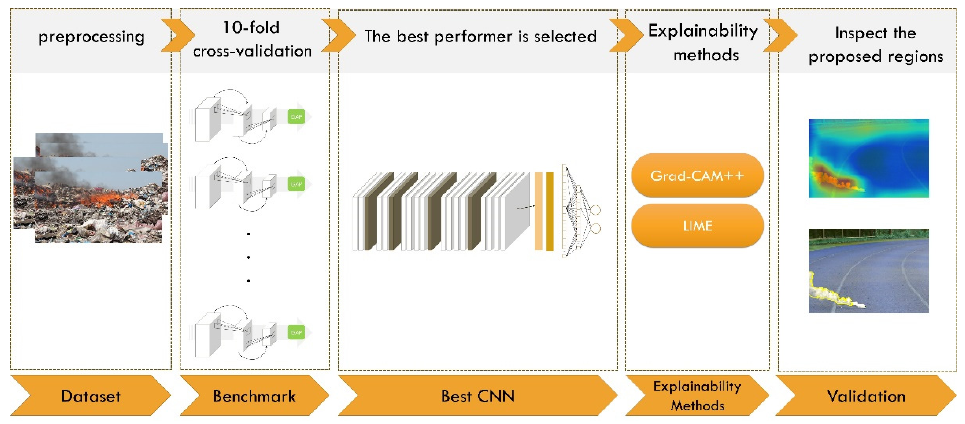
Figure 2. Fire and smoke detection framework.